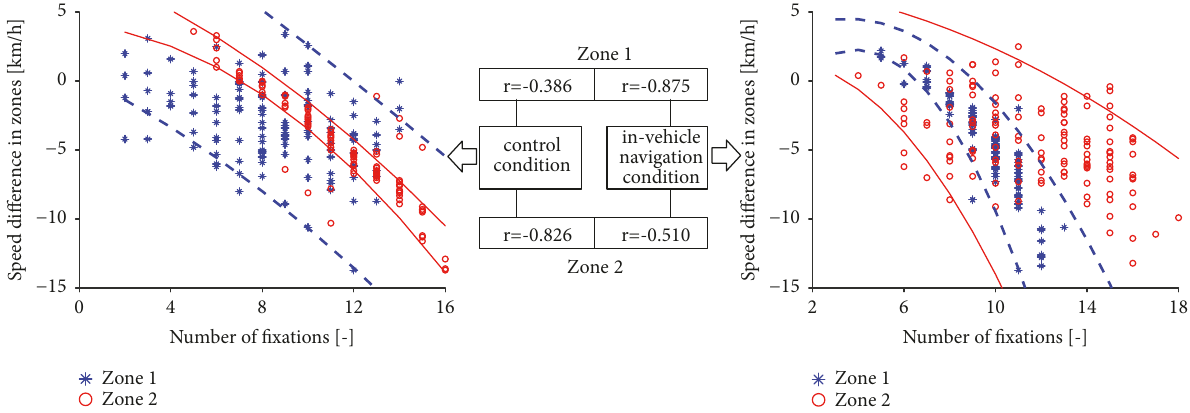
Figure 10: Correlation of visual response and driving behaviour under two